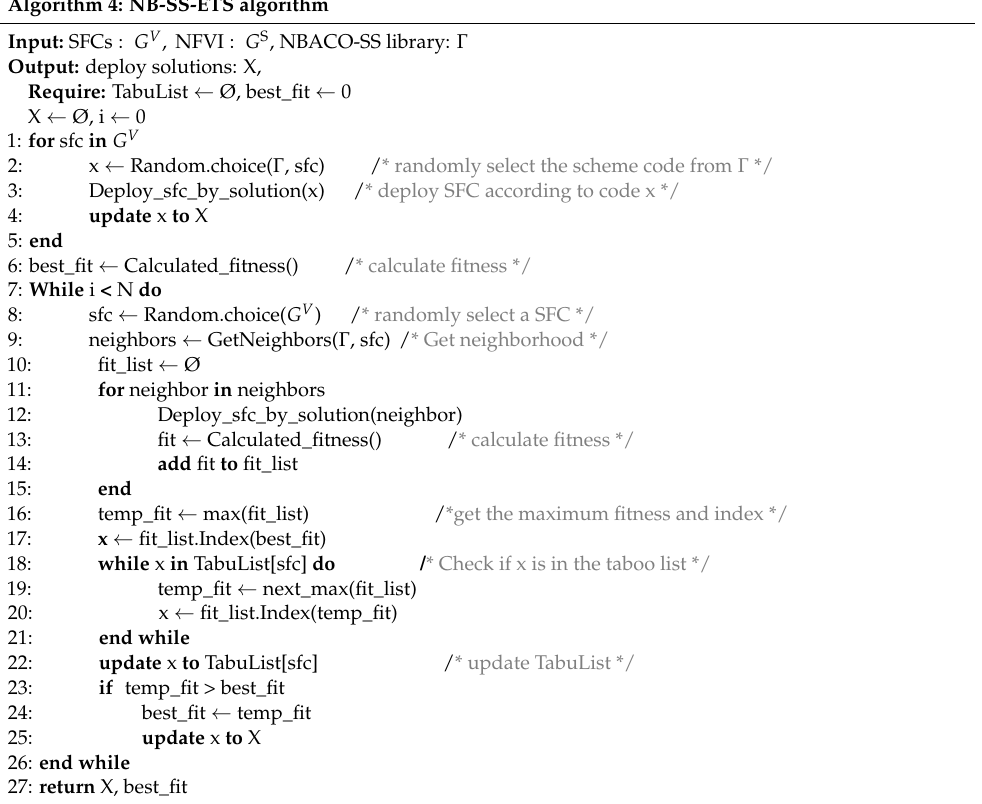
Algorithm 4: NB-SS-ETS